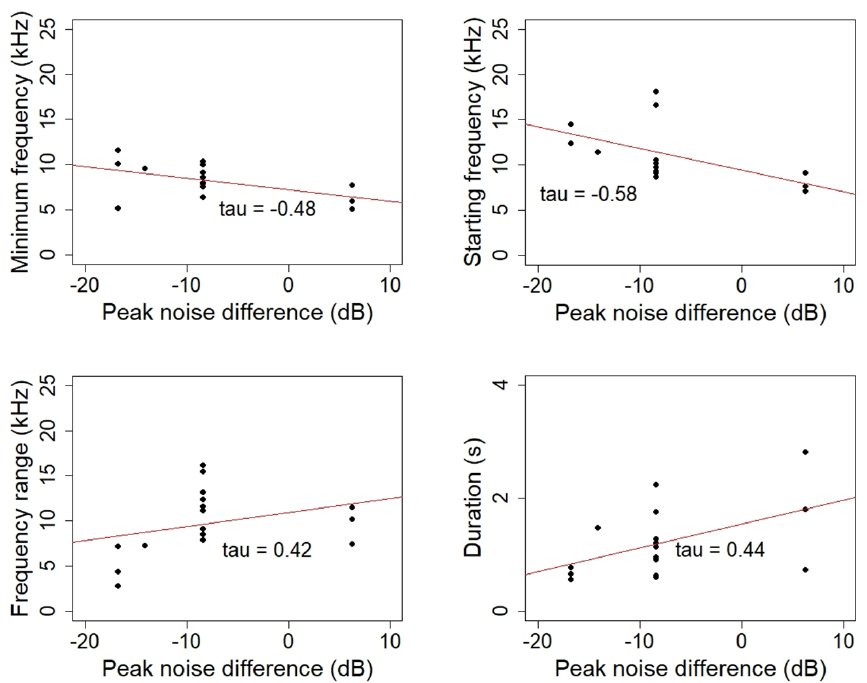
Figure 4. Scatter plots and linear best-fit lines of the whistle parameters of the oceanic ecotype in function of the peak noise difference. Minimum frequency and starting frequency of the whistles were negative correlated with the peak noise difference. On the contrary, frequency range and duration frequency were positive correlated with the peak noise difference.